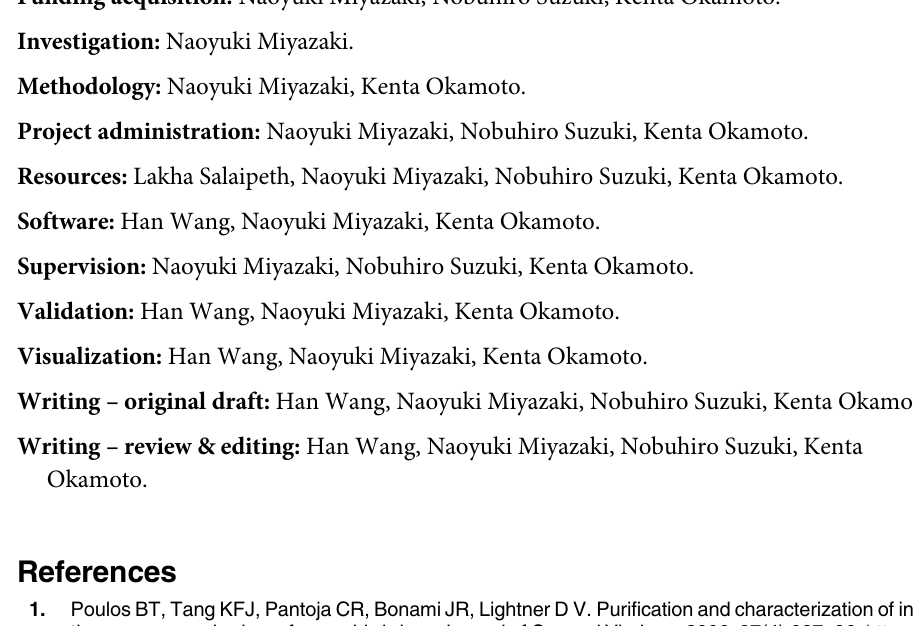
S3 Fig. Atomic model, structural topology, and secondary structural elements of MCP. A) Atomic model of one MCP colored by domains. The protrusion domains (amino acid residues 433–648 and 965–1125) are colored yellow and orange, respectively and the conserved domains (amino acid residues 11–432 and 649–964) are colored dark gray and light gray. The C-terminal arm (amino acid residues 1126–1236) is colored dark blue. B) Structural topology diagram of the MCP. The color codes correspond to those in A). The α -helices and β -strands are shown as red cylinders and light blue arrows and named accordingly. The blue, translu- cent, rounded boxes cover the regions containing β -sheets. C) Amino acid sequence organiza- tion of the MCP. The orange and green boxes highlight α -helices and β -strands, respectively. The colors and labels correspond to those of